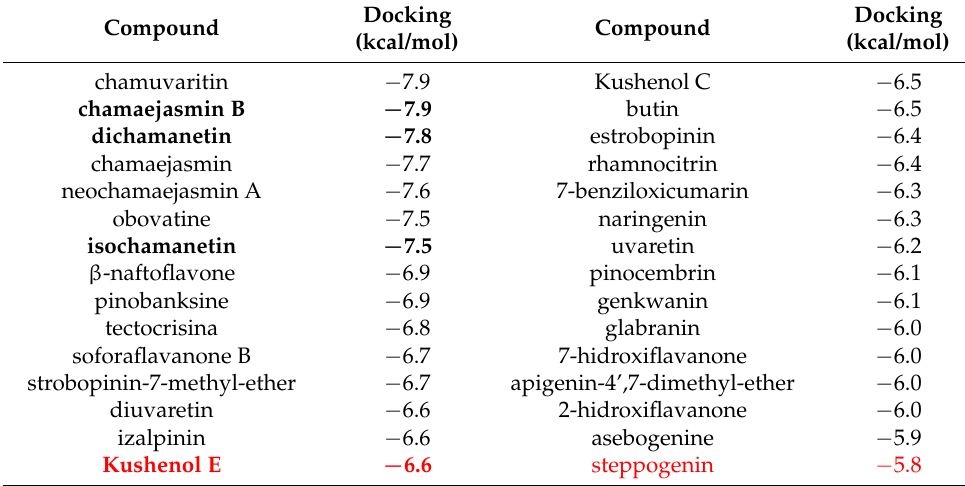
Table 1. Structure-based (second) virtual